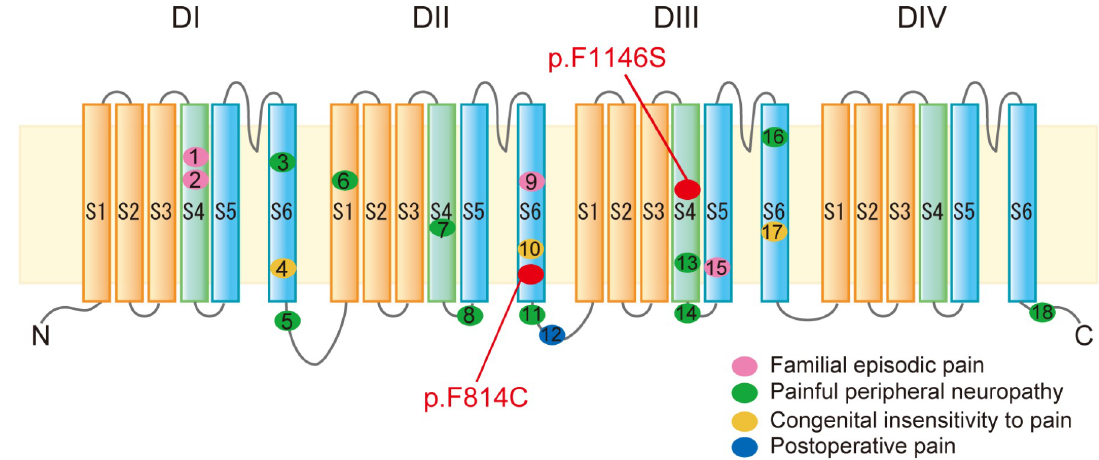
Fig 4. Schematic diagram of Nav1.9 and locations of mutations with pain disorders. Nav1.9 has four domains, each of which consistent of 6 transmembrane segments (S1-S6). S4 segment (S4: green segment) of each domain is voltage sensor, while the S5 and S6 segments (S5, S6: light blue segment) of each domain form the pore region of the voltage gated sodium channel. The novel Nav1.9 mutations p.F814C and p.F1146S are located in the S6 of DII and S4 in DIII. The numbered circles indicate the identified mutations causative of the pain disorders. Phenotypes of disorders are represented by color of the circles; pink, Familial episodic pain; green, Painful peripheral neuropathy; yellow, Congenital insensitivity to pain, blue; Postoperative pain. The numbered locations of each mutation (and their references) are follows: 1, R222H/S (3); 2, R225C (1); 3, I381T (19); 4, L396P (18); 5, K419N (19); 6, A582T (19); 7, A681D (19); 8, G699R (20); 9, A808G (1); 10, L811P (15); 11, A842P (19); 12, V909I (13); 13, L1158P (19); 14, N1169S (21); 15, V1184A (17); 16, I1293V (21); 17, L1302F (15); 18, F1689L